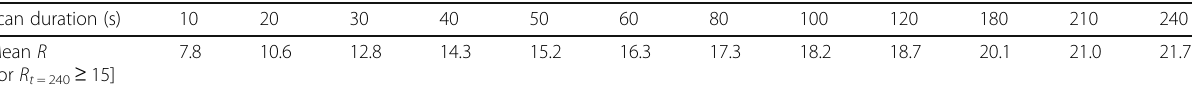
Table 1 Mean R values from all bed positions that satisfied the condition R t =240 ≥ 15 Scan duration (s) 10 240 Mean R [for R t =240 ≥